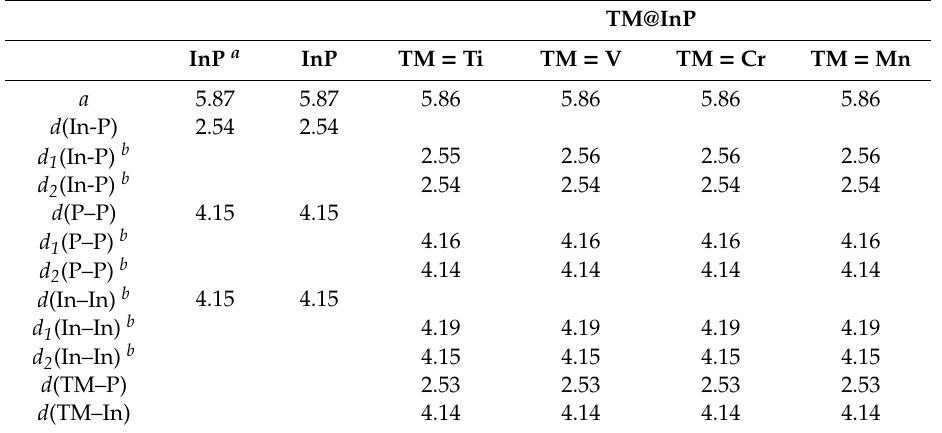
Figure 2. ( a ) Crystal structure of TM@InP along with main bond distances; ( b ) transition metals (TM) in a tetrahedral environment; ( c ) TM in an octahedral environment. Table 1. Lattice parameters ( a ) and bond distances ( d ) obtained for optimized crystal structure of InP and TM@InP by using PBEsol functional along with experimental data of InP. For more details, see Figure 2. Units are in Angstroms